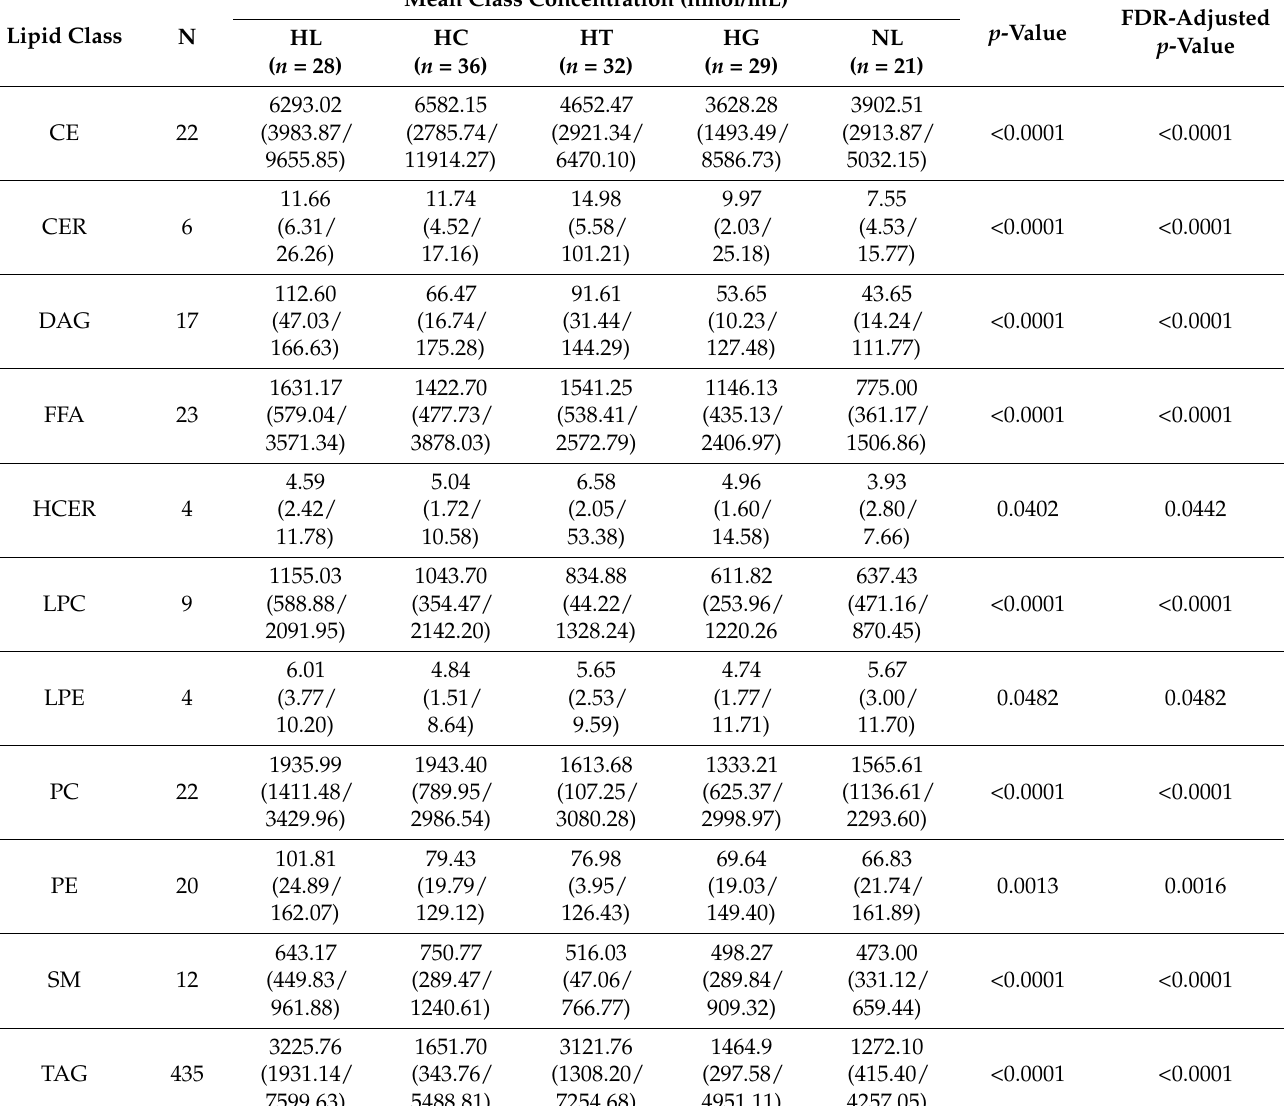
Table 1. Comparison of lipid class concentrations for the metabolic groups. The average lipid concentrations (min/max) were calculated by summing individual species concentrations. One- way ANOVA test was used to determine statistically significant differences between sample groups ( p -value < 0.05 was considered